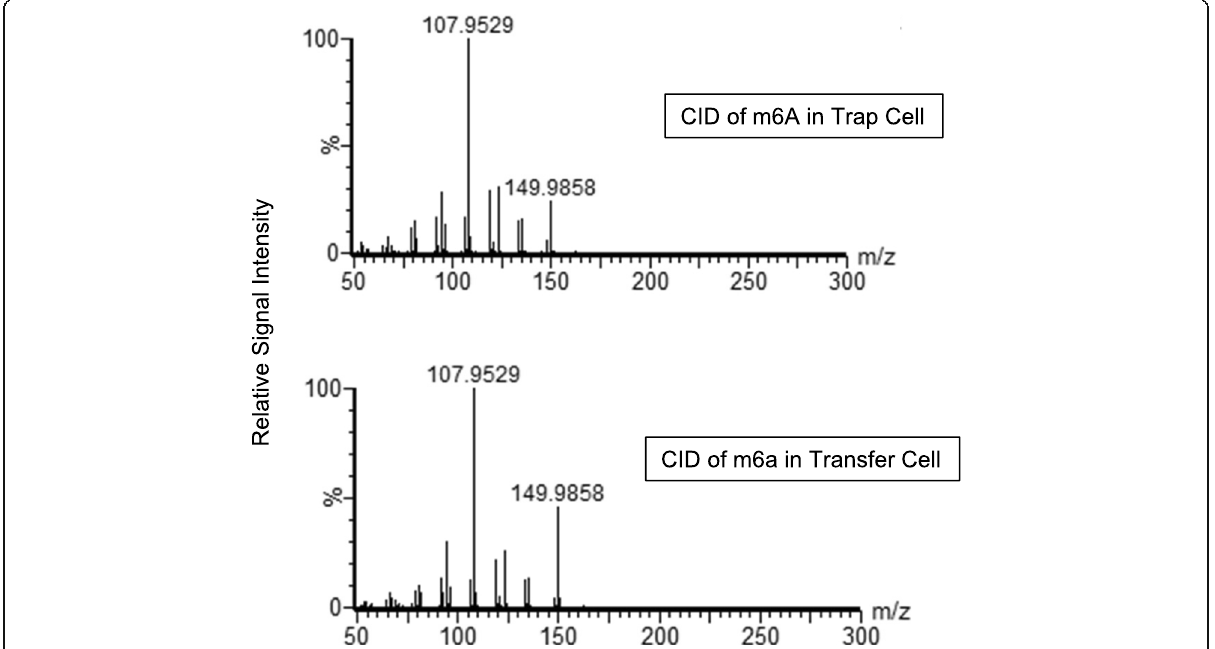
Fig. 4 MS/MS spectrum of m6A in the trap cell under the standard MS/MS method or m6a in the transfer cell under the SRI method. The CID energy used in the trap and transfer cell was 80 V and 160 V, respectively. The ion counts for 107.9529 m/z ion in both cases reached 2e+4 and 5e+4, respectively